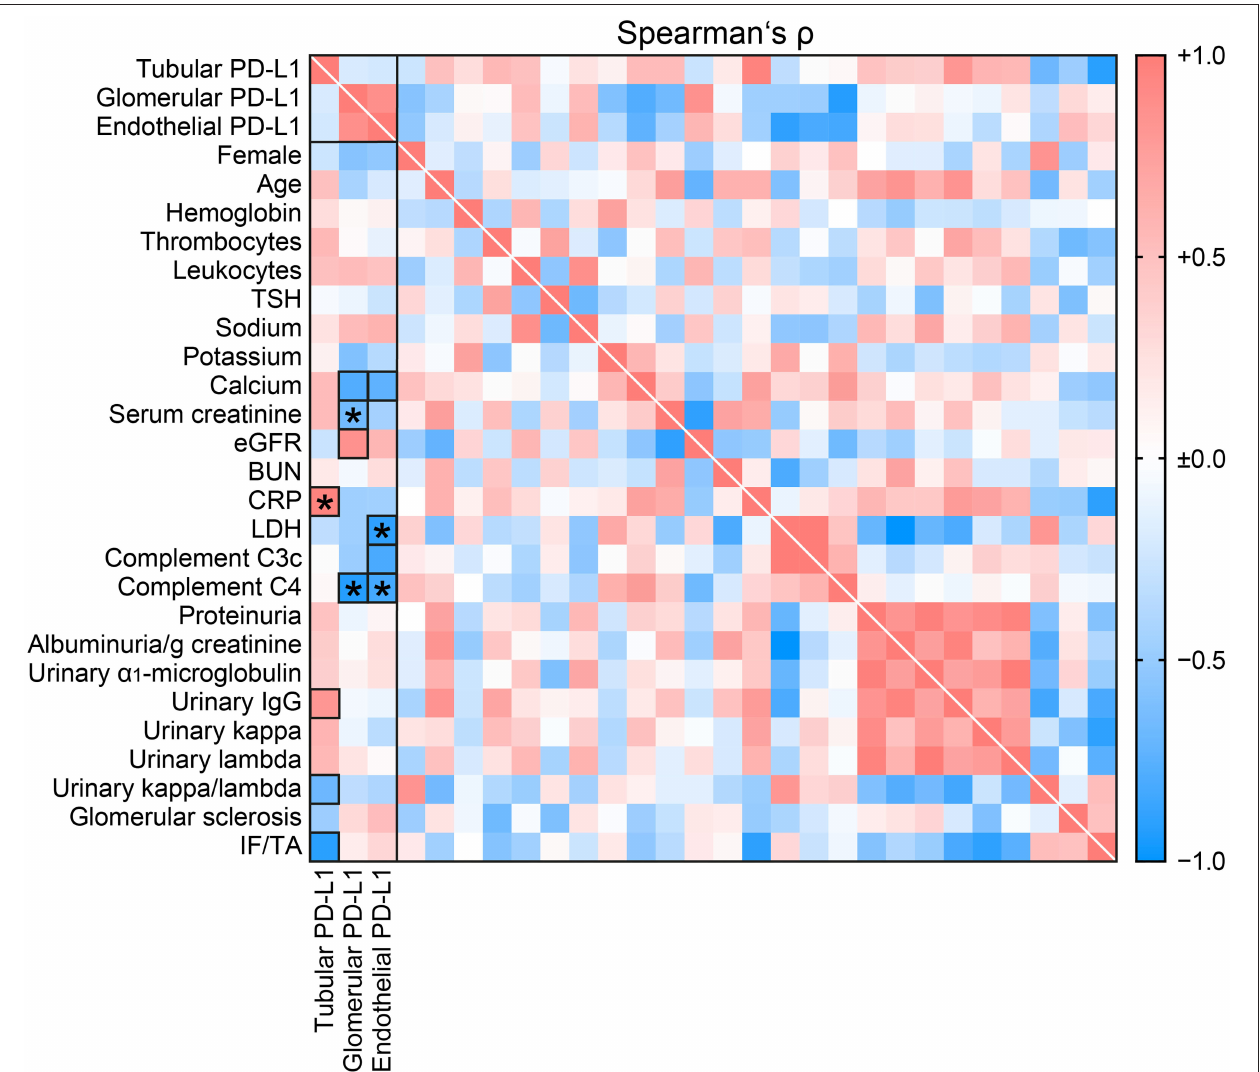
FIGURE 2 | Compartmentalization of renal PD-L1 is associated with systemic inflammation and complement system activation. Intensity of PD-L1 positivity within different renal compartments in ICI-related nephrotoxicity in association with clinical and laboratory parameters are shown by heatmap reflecting mean values of Spearman’s ρ . Rectangle boxes indicate a Spearman’s ρ more than ± 0.6, asterisks significant correlations in the stepwise linear regression analysis ( p < 0.05). AIN, acute interstitial nephritis; BUN, blood urea nitrogen; C3c, complement factor 3 conversion product; C4, complement factor 4; CRP, C-reactive protein;